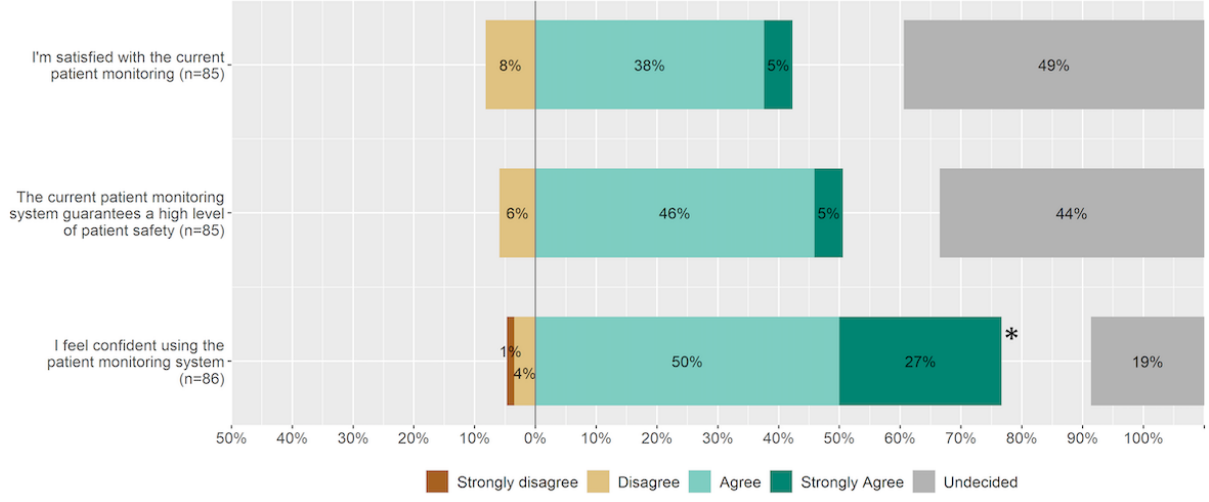
Figure 1. ICU staff experience with current patient monitoring. An asterisk indicates statistical significance. ICU: intensive care